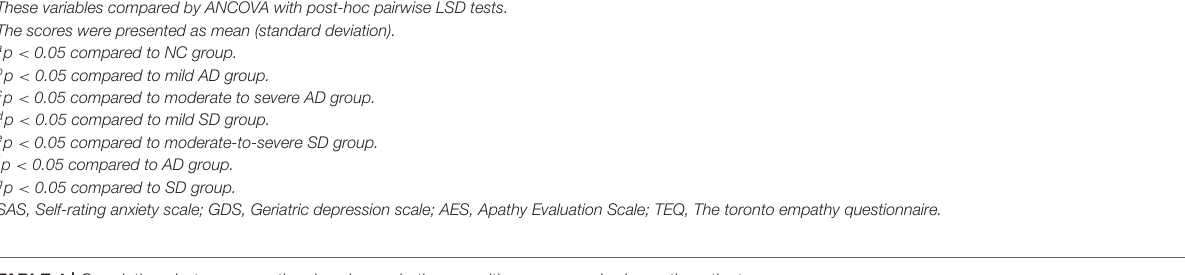
TABLE 4 | Correlations between emotional scales and other cognitive measures in dementia